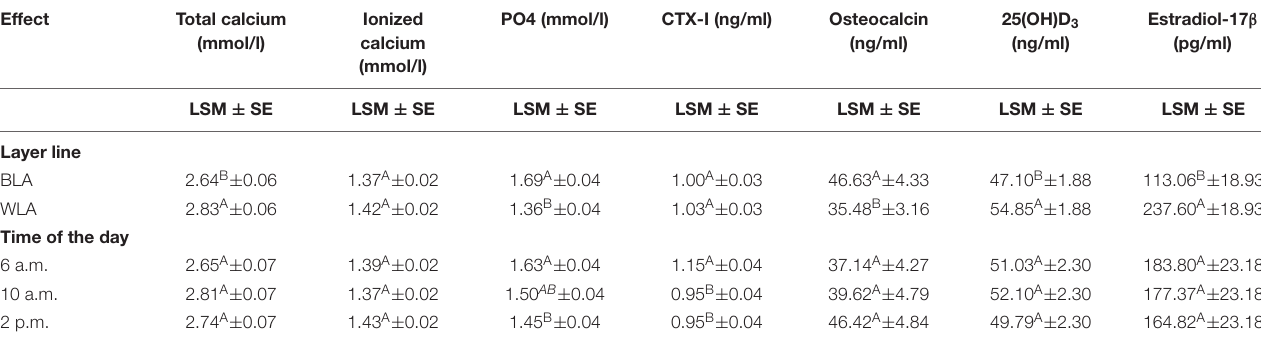
TABLE 1 | Least square means (LSM), their standard errors (SE) and significant differences between the effect levels for blood concentrations of total and ionized calcium, inorganic phosphate (PO4), the carboxyterminal crosslinked telopeptide of type I collagen (CTX-I), osteocalcin, 25-hydroxycholecalciferol (25(OH)D 3 ) and estradiol-17 β of the blood of brown-(BLA) and white-egg (WLA) laying hens examined in the 17th week of age.